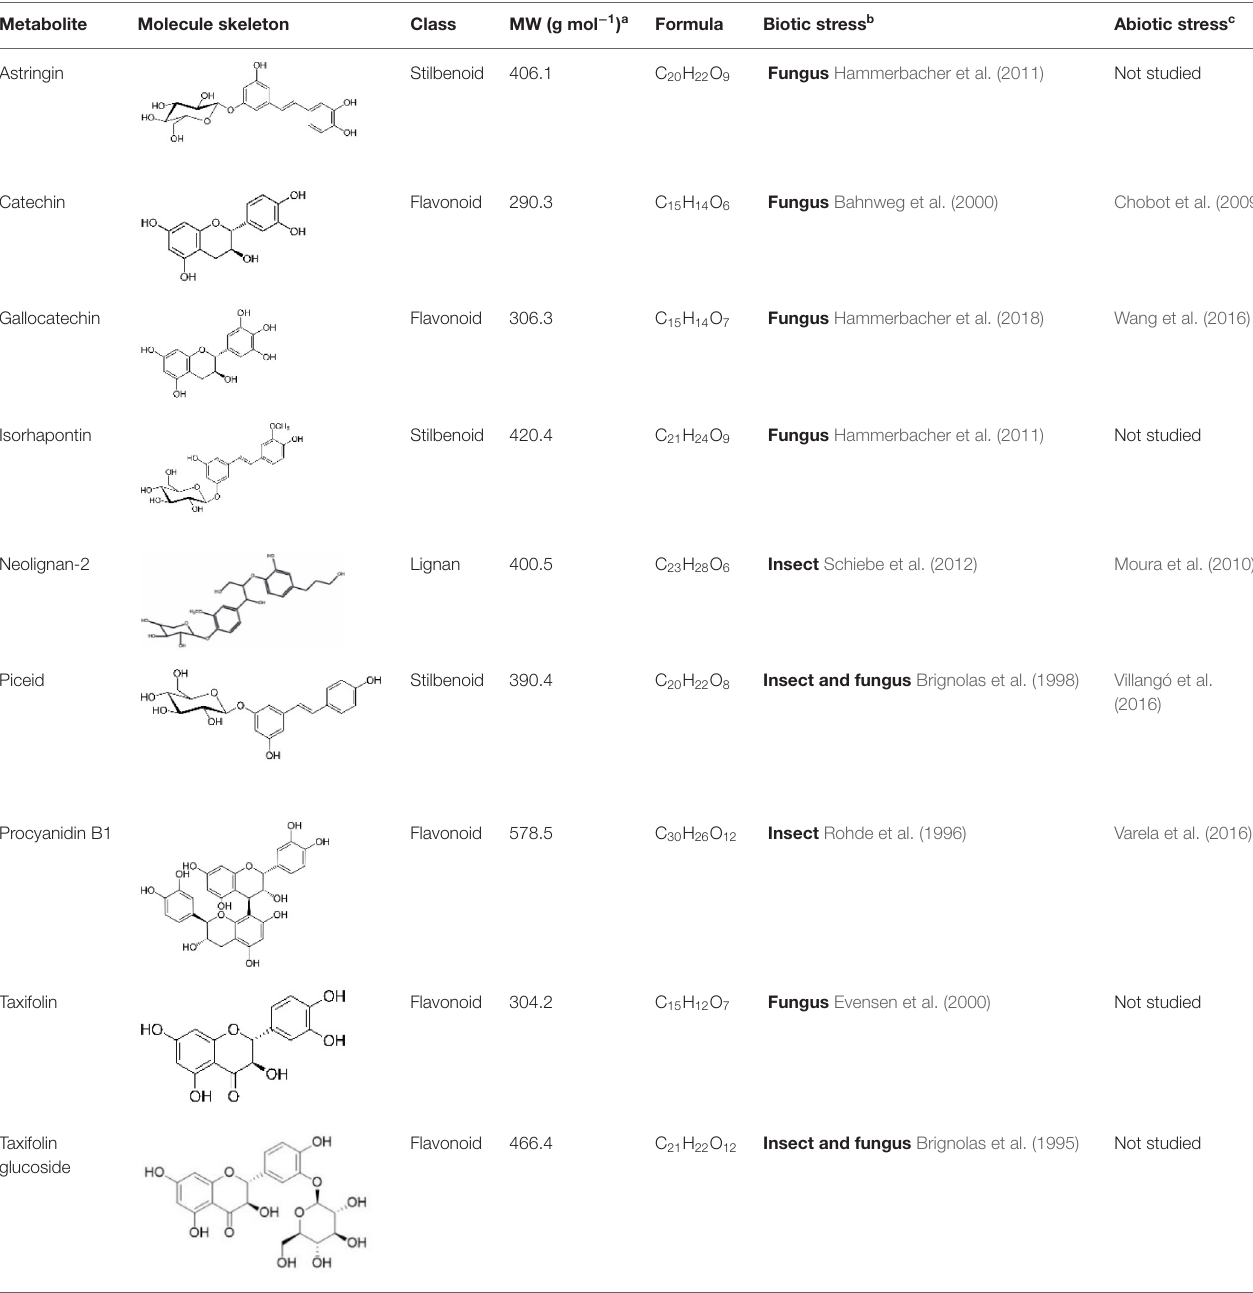
TABLE 1 | Bark phenolic compounds analyzed in a white spruce full-sib